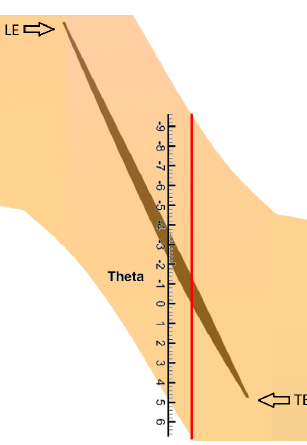
Figure 12. Parameter distributions at NS.